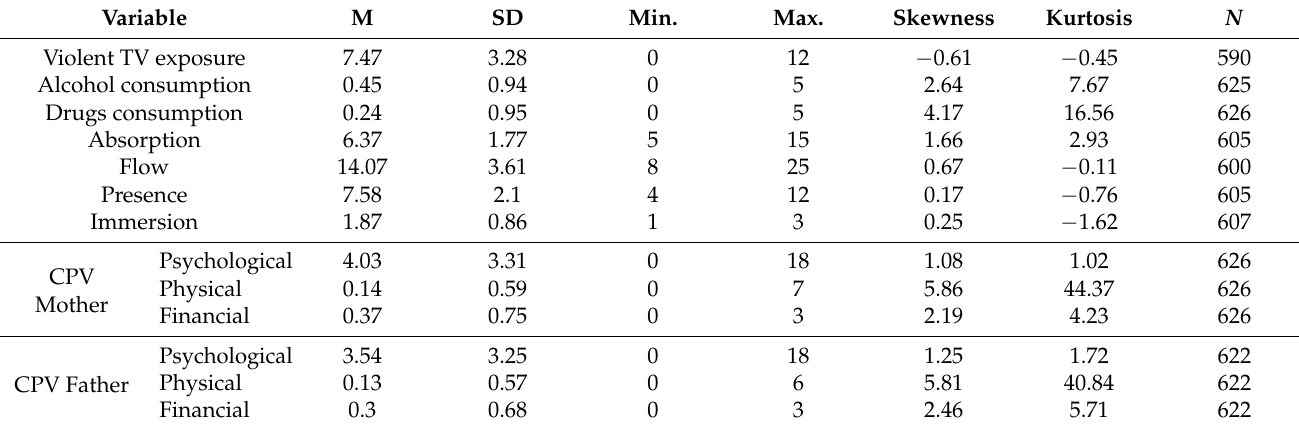
Table 1. Descriptive statistics of exposure to violence on TV, substance use, video games engagement and child-to-parent violence (CPV) among video games